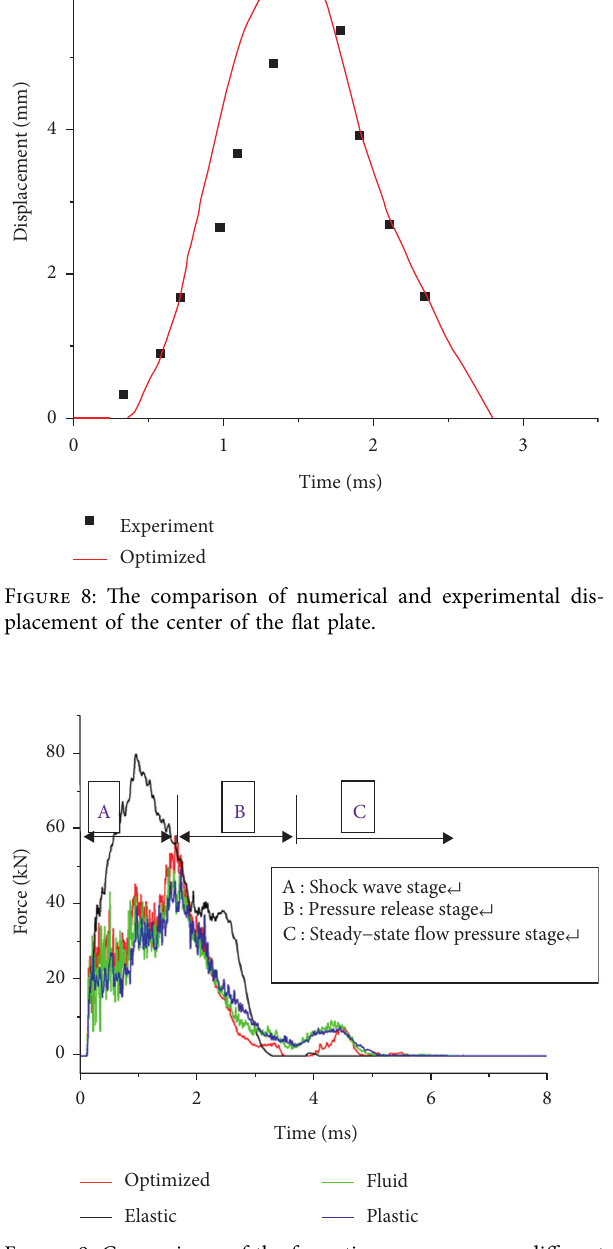
Figure 9: Comparisons of the force-time curves among different